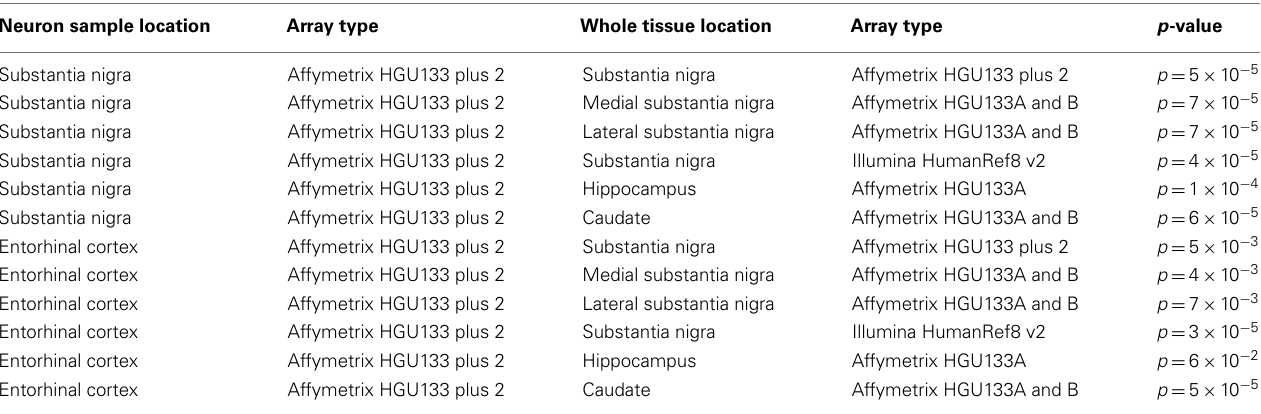
Table 5 | Higher X:Autosome ratio for laser dissected neurons than whole tissues.